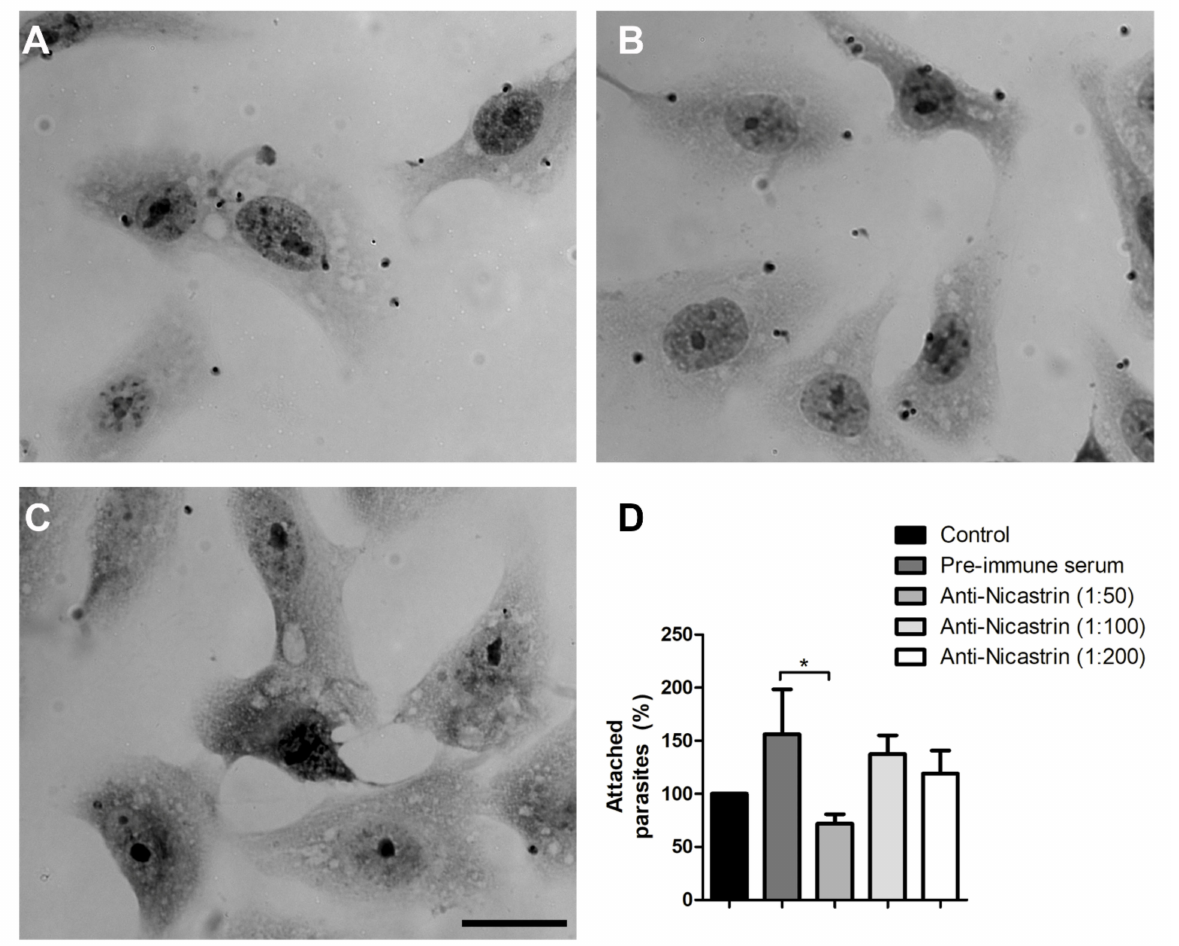
Figure 4. Analysis of host cell-trypomastigote interactions after nicastrin blocking using anti-Tc/NICT-1 sera. Light microscopy images of T. cruzi attached to Vero cells 2 h after parasite addition. Trypomastigotes were pre-incubated for 1 h with medium ( A ), pre-immune rabbit sera ( B ) or anti-Tc/NICT-1 sera at a dilution of 1:50 ( C ). The number of trypomastigotes attached to the cellular surface was quantified, and the percentage of bound parasites was calculated using the untreated group as 100% (Control). ( D ) The number of parasites was determined by random quantification of at least 100 cells from each replicate. * Significant difference using t -test ( p < 0.05). Scale bar = 20 µ